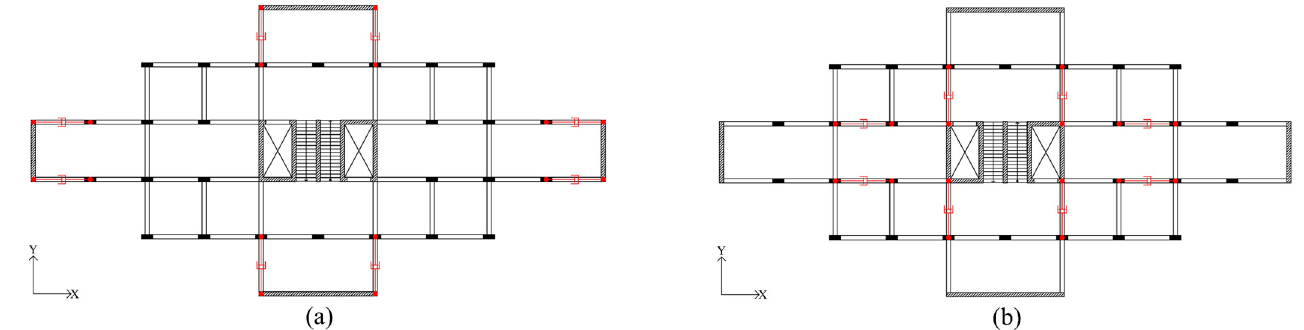
Figure 8. ( a ) Alternative 1 of dampers placement and ( b ) Alternative 2 of dampers placement.